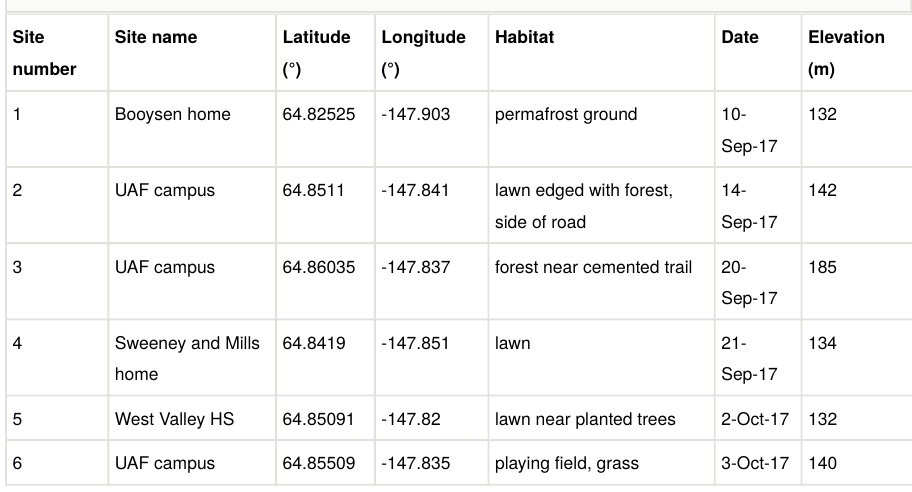
Since earthworms are thought to be most active during the spring and the fall (autumn) months (Gates 1961, Rogers and Collins 2017), we conducted standardised sampling during late summer and fall 2017. We selected locations across the Fairbanks vicinity in six relatively natural yet diverse areas (Table 1). Our standardised sampling locations were mostly in the College region of Fairbanks. Some sites were on the campus of the University of Alaska Fairbanks, which has been the site of an Agricultural Experiment Station since 1906. Elevations ranged over a span of 53 metres between the lowest and highest sites (#1 and #3). Table 1. Interior Alaska sites sampled using mustard